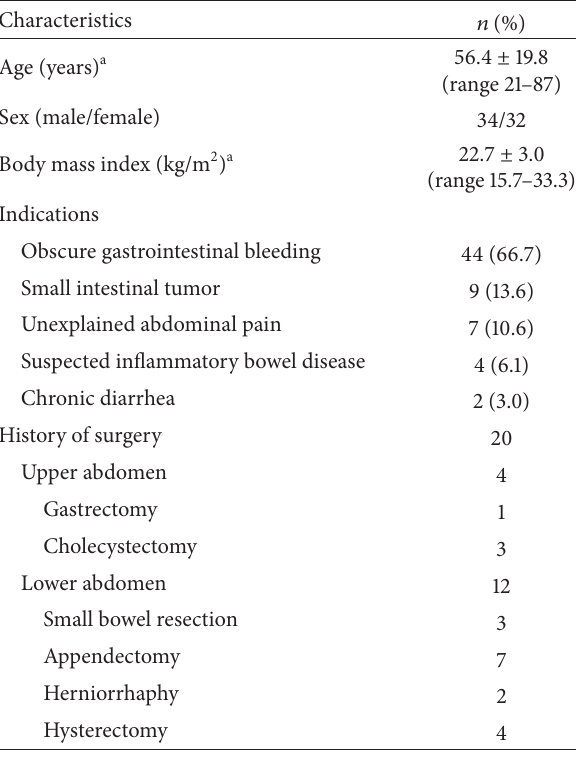
Table 1: Clinical characteristics of the patients enrolled for retro- grade SBE ( 𝑛 = 66 ).